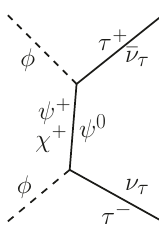
Figure 1 . Pair annihilation